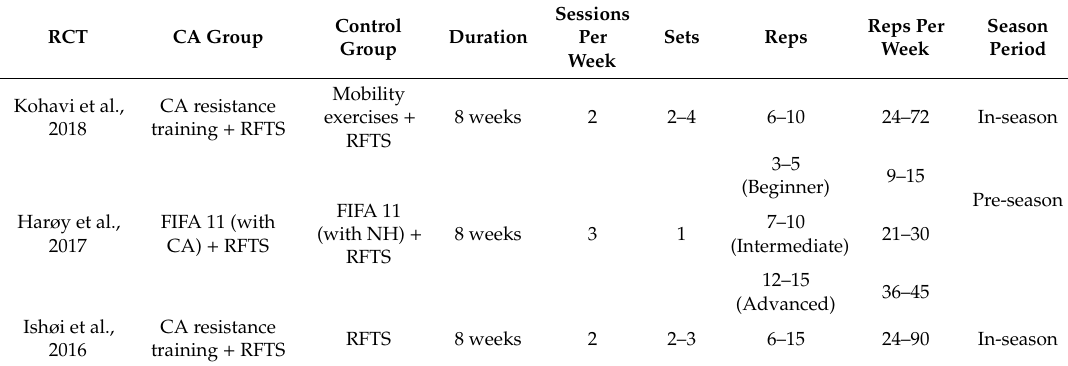
Table 2. Characteristics of the interventions.